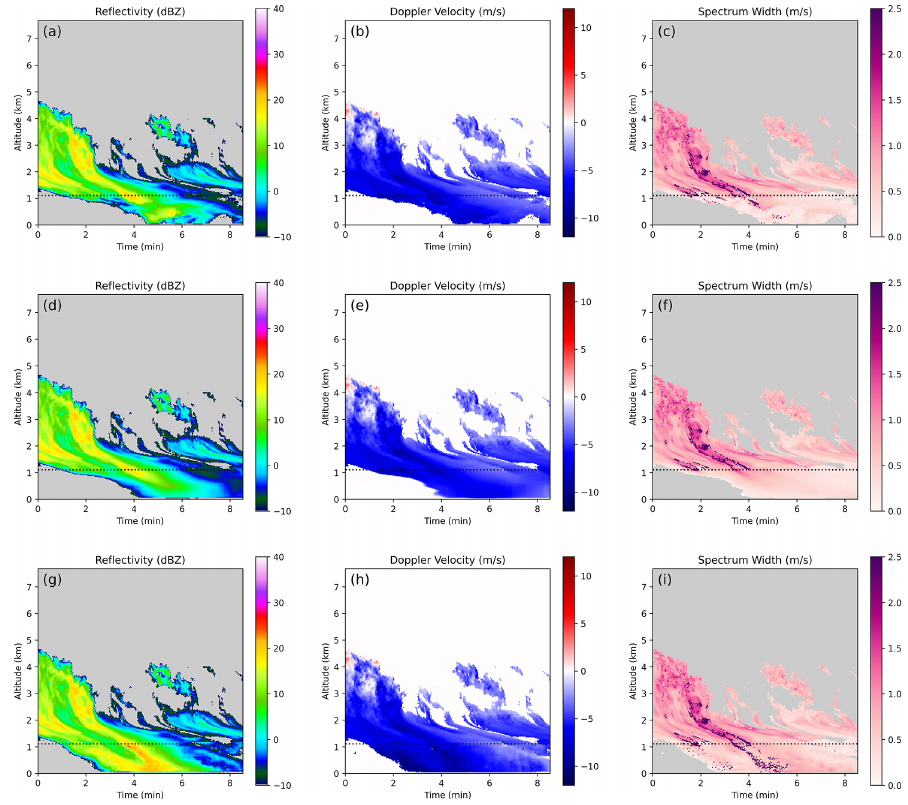
Figure 5. An example of inpainting a KaZR low-level blind zone. (a – c) Ground truth, (d – f) conventional CNN inpainting, and (g – i) CGAN